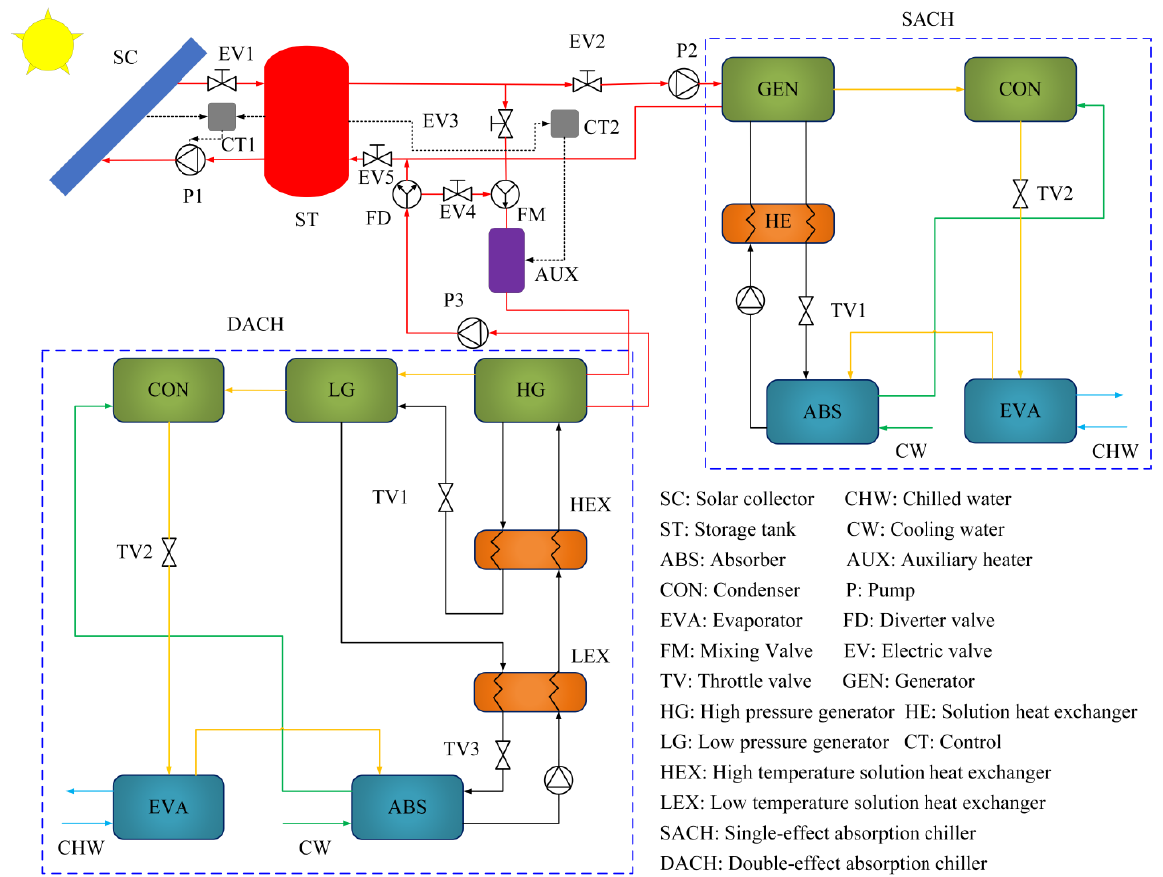
Figure 1. Schematic diagram of solar single/double-effect ARS.